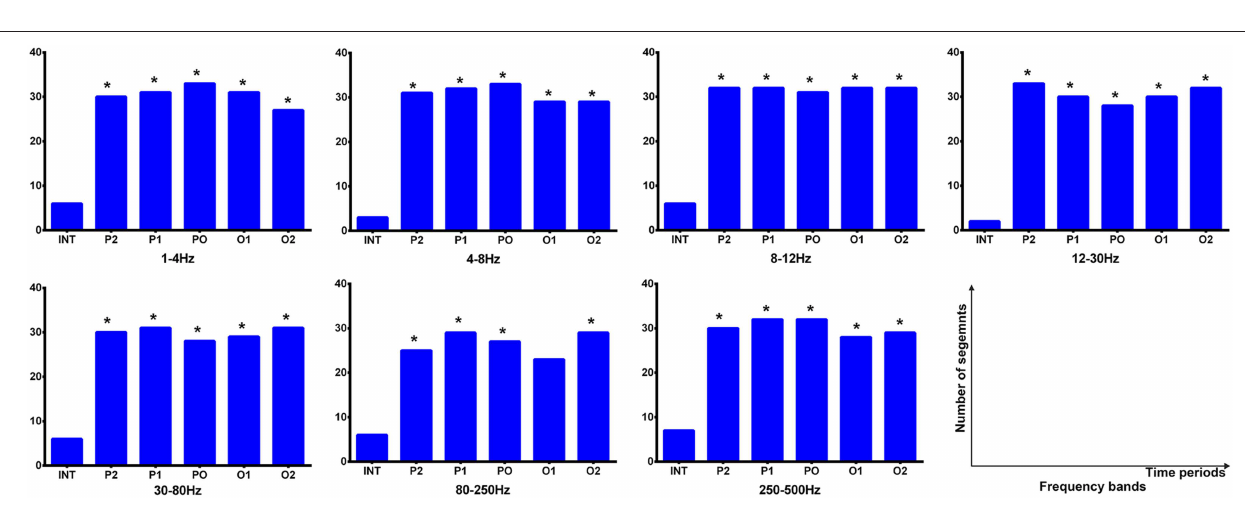
FIGURE 5 | Cortico–thalamic EC during interictal and offset transition periods in seven frequency bands. The y-axis indicates the numbers of segments (total 33 segments for the offset transition periods, which represents 33 seizures analyzed from 15 CAE patients; total 15 segments for the interictal periods indicating 15 interictal MEG segments for control) where cortico–thalamic EC exists during corresponding periods. For all frequency bands, the transition (P2, P1, PO, O1, and O2) and interictal (INT) periods showed significant differences (marked with asterisks). * p < 0.05 after FDR (corrected for 7 × 5